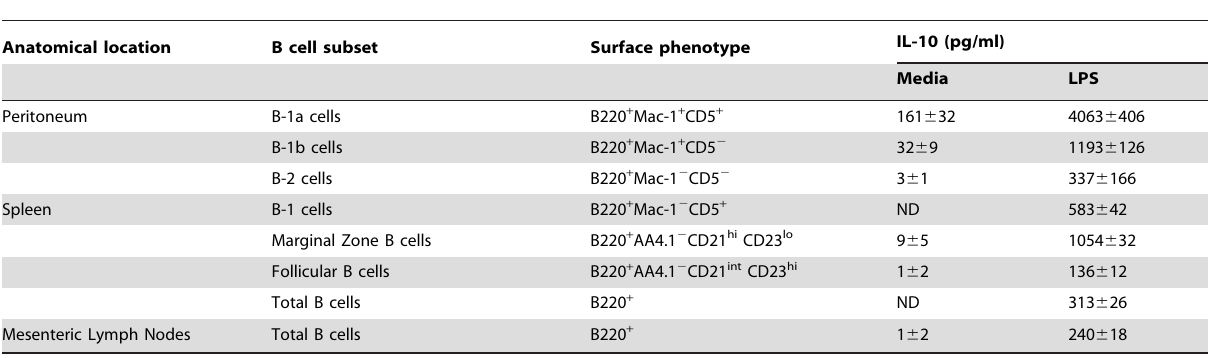
Table 2. Constitutive and LPS induced IL-10 production by various murine B cell subsets.